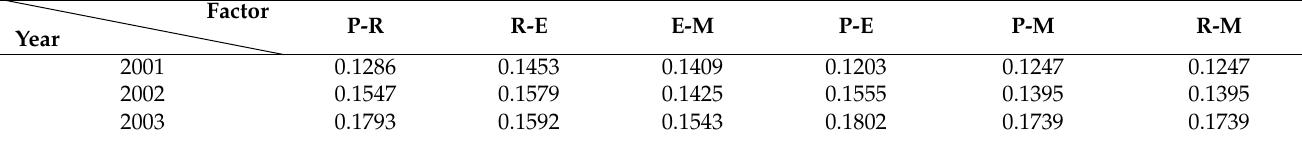
Table 7. The coupling coordination degree K j of two